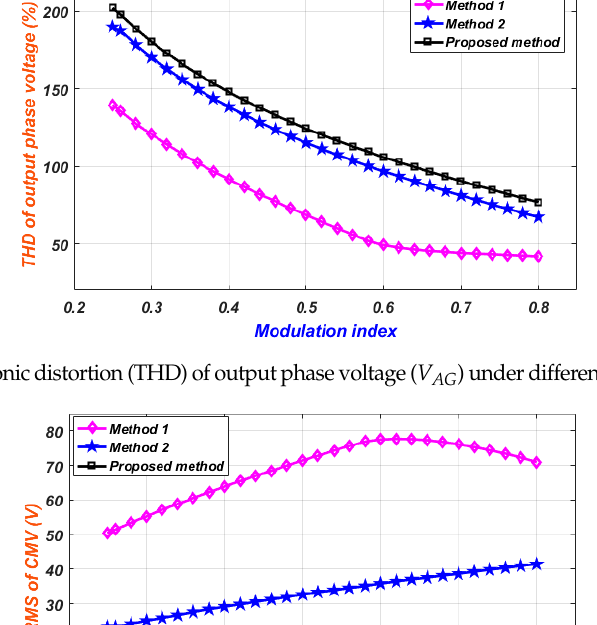
Figure 11. Experimental results of the DC input voltage ( V g ), capacitor voltages ( V C 1 and V C 2 ), and inductor current ( I L ) of the proposed method. Figure 12 shows the experimental waveform results of the DC-link voltage, phase voltage ( V AG ), and CMV of three methods. For method 1, presented in Figure 12a, the variation of the DC-link